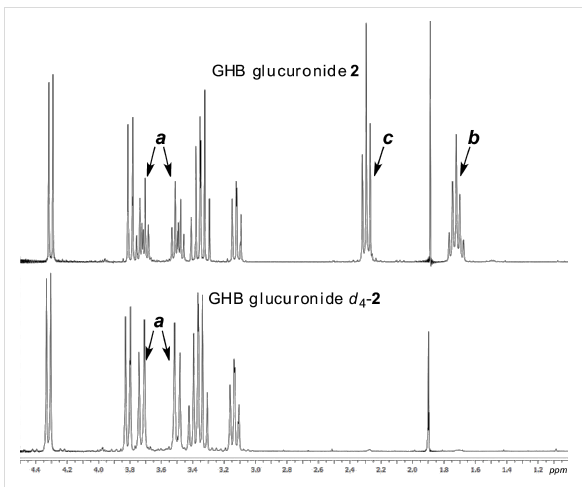
Figure 2: 1 H NMR spectrum (D 2 O, 300 MHz) of GHB glucuronides 2 (top) and d 4 - 2 (bottom). As anticipated, methylene protons b and c are absent in d 4 - 2 (cf. labelling in Scheme